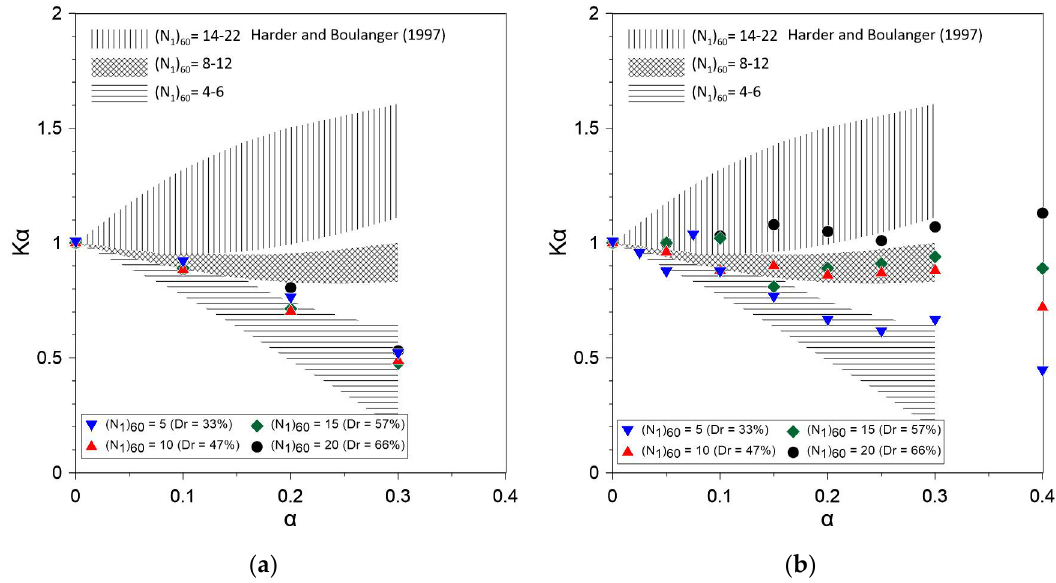
Figure 8. Static shear stress effects on the CRR and comparison with curves in the NCEER procedure. ( a ) Finn model; ( b ) model (modified from Beaty and Byrne, 2011) [19].